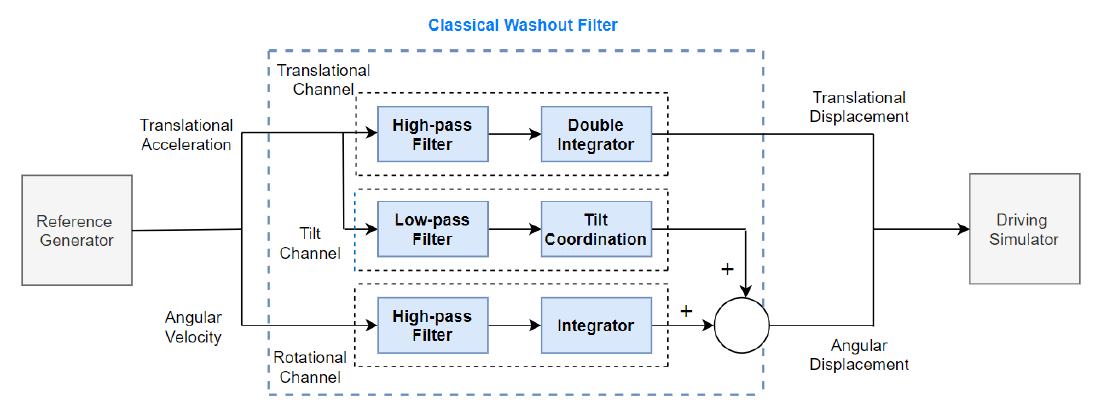
Figure 1. Scheme of classical washout filter-based